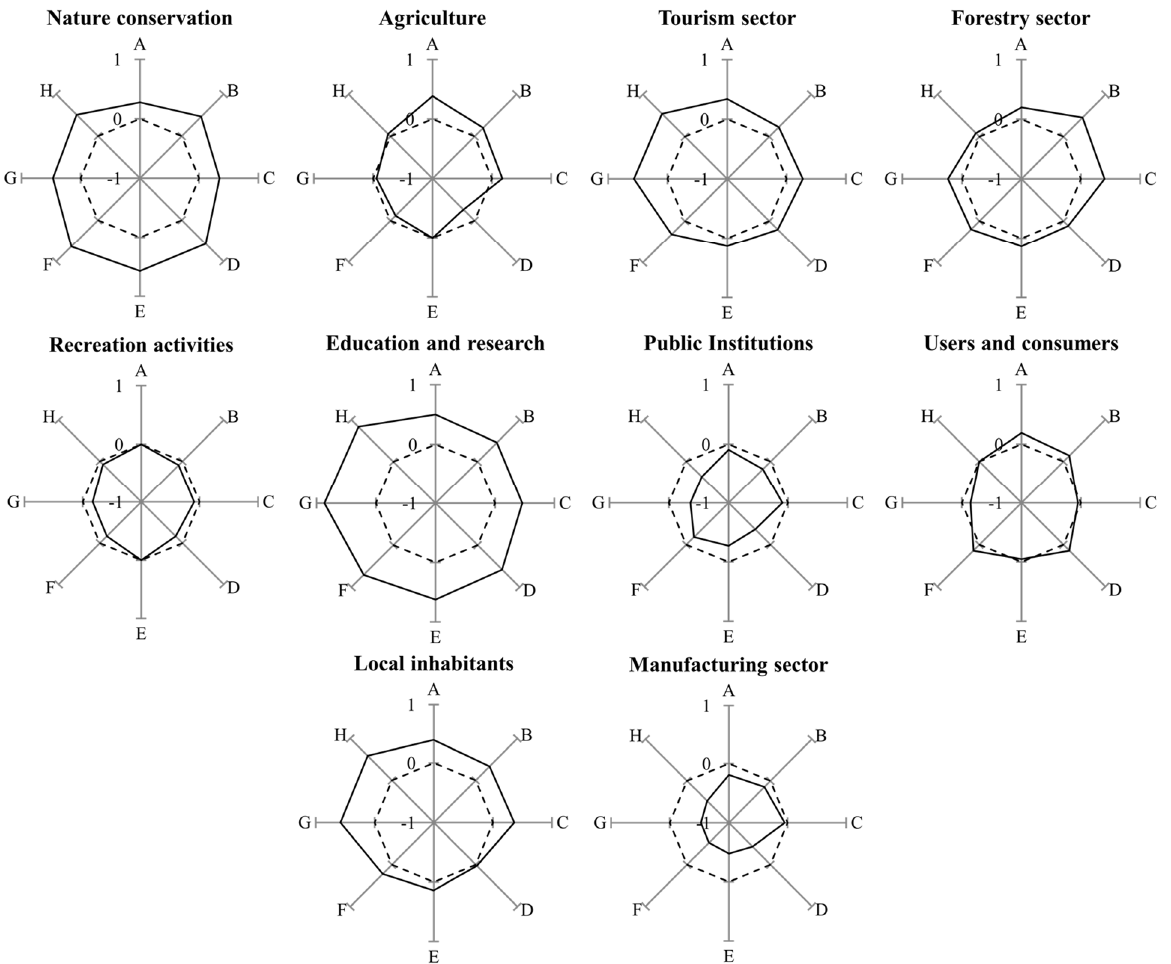
Figure 5. Spider charts showing the different impacts of stakeholder typologies (top of the charts) on FES. Impacts are represented by solid lines, and related values range between − 1 (negative) to 1 (positive). No impact corresponds to 0 value. Impacted services are lettered on chart’s crowns as follows: non-wood forest products/fresh water availability (A); Production of raw materials (B); Timber extraction for energy supply (C); Bioremediation (D); Hydrogeological protection (E); Biodiversity conservation and climate change mitigation (F); Improvement of tourism and recreation concerns (G); and Conservation